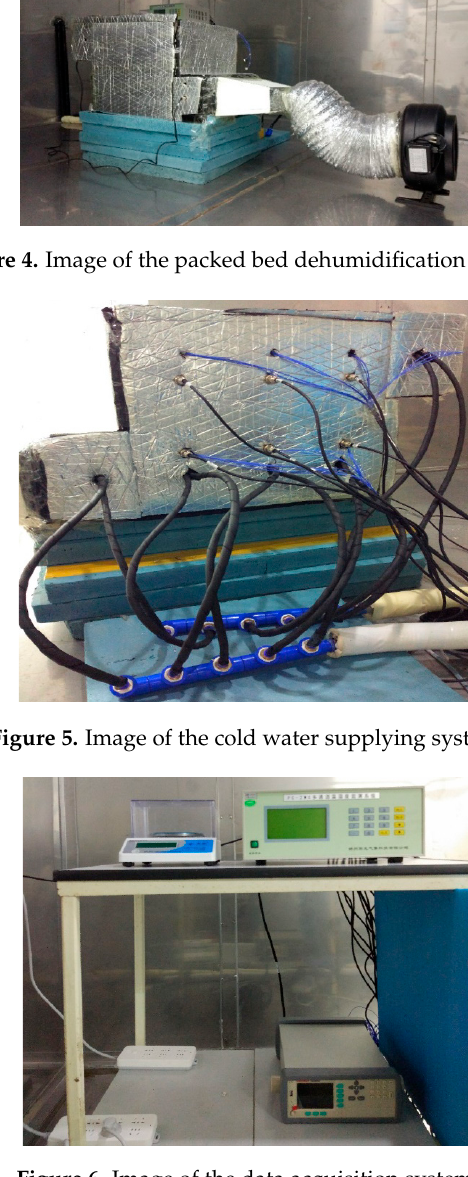
Figure 6. Image of the data acquisition system. Table 1. The parameters of main